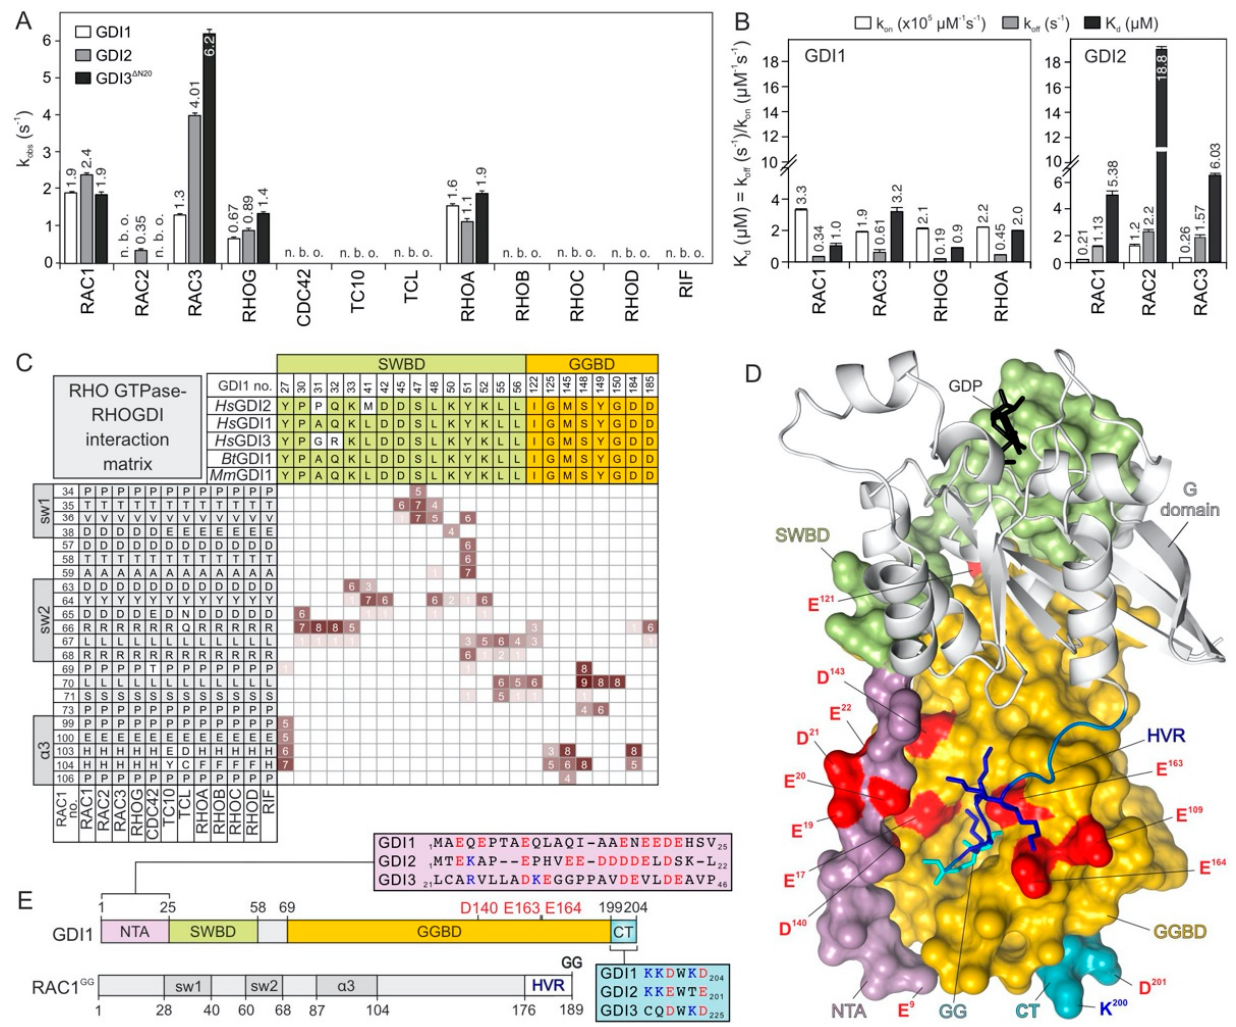
Figure 2. Biochemical and structural view into the RHO GTPase-GDI interactions. ( A ) Kinetics of association of 2 µ M GDI proteins (GDI1, GDI2 and GDI3 ∆ N20) with 0.2 µ M mdGDP-bound RHO GTPases (twelve different proteins) was only monitored for RAC1, RAC3, RHOG and RHOA using stopped-flow fluorimetry. GDI2 but not GDI1 and GDI3 associated with RAC2. No binding was observed (n. b. o.) for the other GTPases. Obtained k obs values are the average of four to six independent fluorescence measurements, consisting of 1000 data points each (mean ± S.D.). Kinetic data are shown in Figure S2. ( B ) Individual rate constants were determined, under the same conditions as shown in Figure 1A–C, for the interaction of GDI1 with RAC1, RAC3, RHOG and RHOA, and GDI2 with RAC1, RAC2 and RAC3, respectively. Kinetic data were derived from the average of four to six independent measurements (mean ± S.D.). Kinetic data are shown in Figure S3. ( C ) An interaction matrix of the GDI proteins with twelve RHO family GTPases is generated to determine the frequency of contacts in respective structures. (see Table S2; for more detail see Figure S4). It comprises the amino acid sequence alignments of the RHO proteins (lower left panel) and the GDIs (upper right panel), respectively. Each element corresponds to a possible interaction of RHO residues (row; RAC numbering) and GDI residues (column; GDI1 numbering). The number of actual contact sites between RHO and GDI proteins (with distances of 4 Å or less) were calculated and are indicated with numbers for matrix elements between 1 and 9. ( D ) A detailed view into the structure (PDB code: 1HH4) of GDP-bound RAC1 GG (grey ribbon) in complex with GDI1 (surface representation) revealed that the basic HVR (blue) is sandwiched between a series of acidic residues of GDI1 supplied by NTA (purple) and GGBD (orange). ( E ) Schematic diagrams of the domain organizations of GDI1 and RAC1 GG illustrate their detailed boundaries. Amino acid sequence alignments of the N-terminal arm (NTA; 25 amino acids) and the C-terminal six residues of the GDI proteins (boxed) highlight negatively and positively charged residues (red and blue). Colors are the same in ( D ). To examine binding properties, the respective association rate constants (k on ) and the dissociation rate constants (k off ) were determined for the interaction of GDI1 with RAC1, RAC3, RHOG and RHOA, and GDI2 with RAC2 under conditions described above (Fig- ures 1A–D and S3A). All kinetic parameters along with calculated dissociation constants (K d ) are summarized in Figure 2B. The data are very similar for the GDI1 interaction with RAC1, RAC3, RHOG and RHOA with K d values between 0.9 and 3.2 µM. However, GDI2